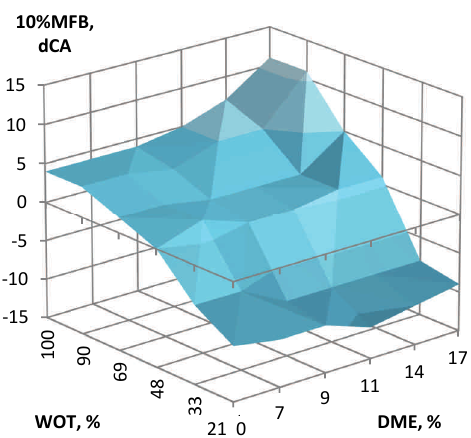
Fig. 13. A point of 10% MFB during combustion process, n = 2500 rpm